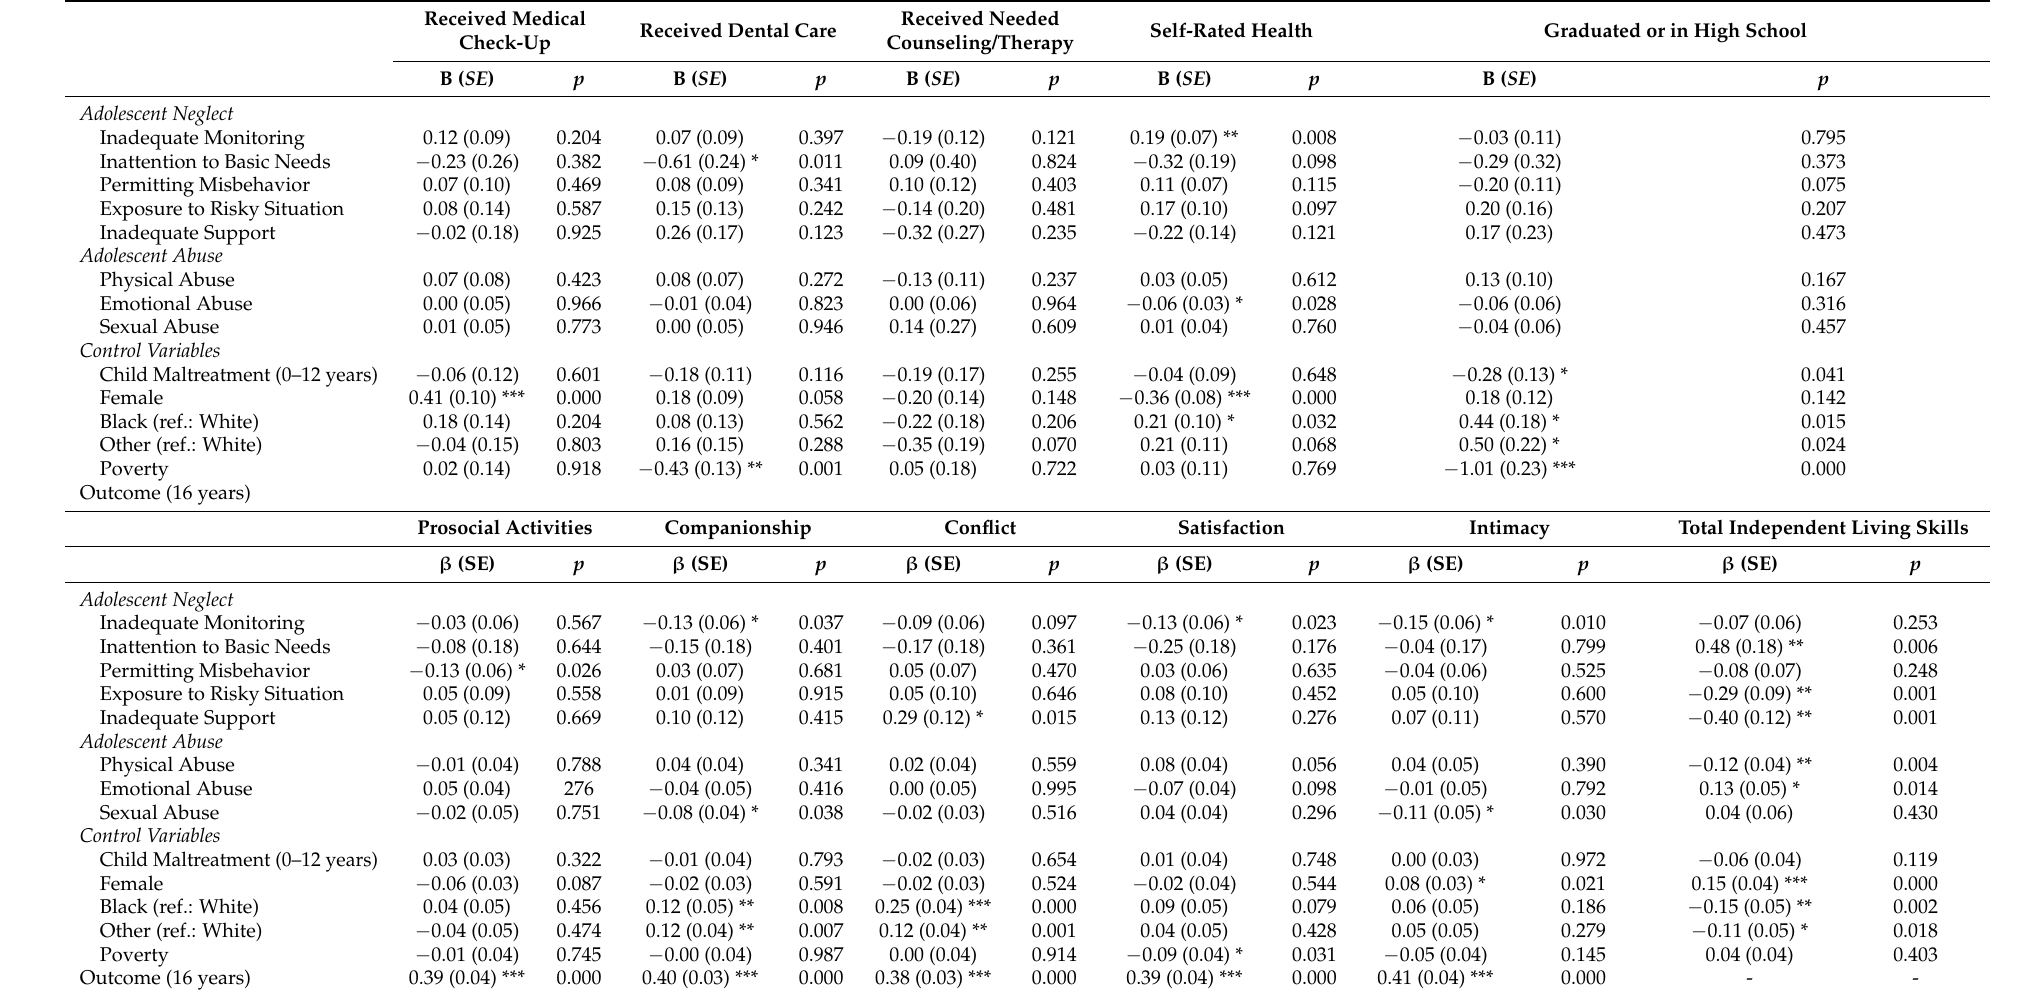
Table 2. Structural Equation Model Predicting Functional Adaptations ( N =